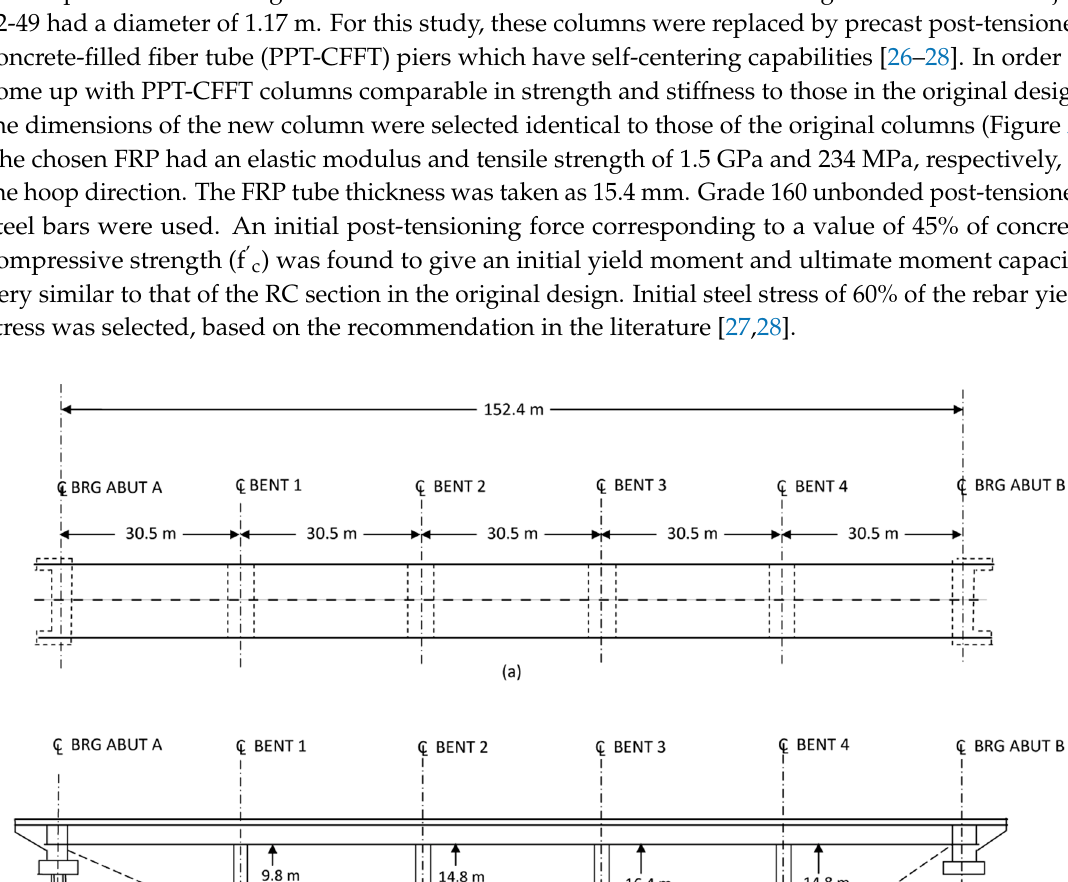
Figure 2. Column cross-section.